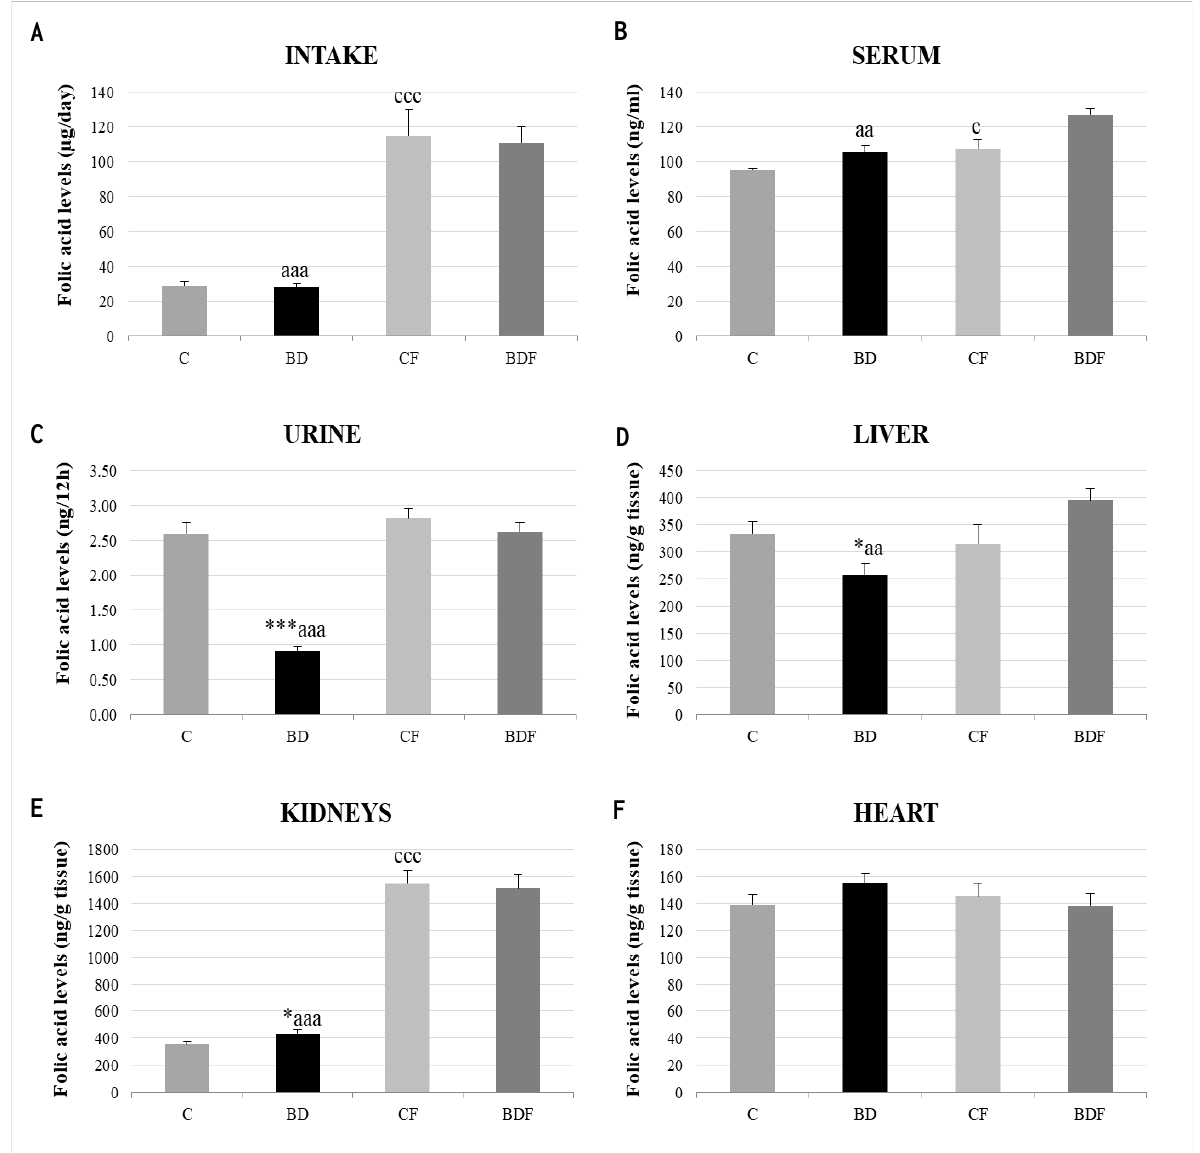
Figure 1. Folic acid homeostasis in the rats’ bodies. Intake levels ( A ), serum levels ( B ), urine levels ( C ) and tissue deposit levels in the liver ( D ), kidneys ( E ) and heart ( F ). The results are expressed as mean ± SEM and analysed by a multifactorial one-way ANOVA followed by Tukey’s test. The number of animals in each group is 6 and n = 12. SEM: standard error of the mean. Groups: C: control group, BD: binge drinking group, CF: control folic group, BDF: binge drinking folic group. Signification: C vs. BD: * p < 0.05, *** p < 0.001; C vs. CF: c p < 0.05, ccc p < 0.001; BD vs. BDF: aa p < 0.01, aaa p < 0.001.